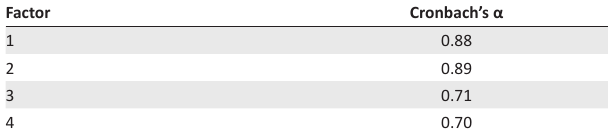
TABLE 3: Cronbach’s alpha for the four identified